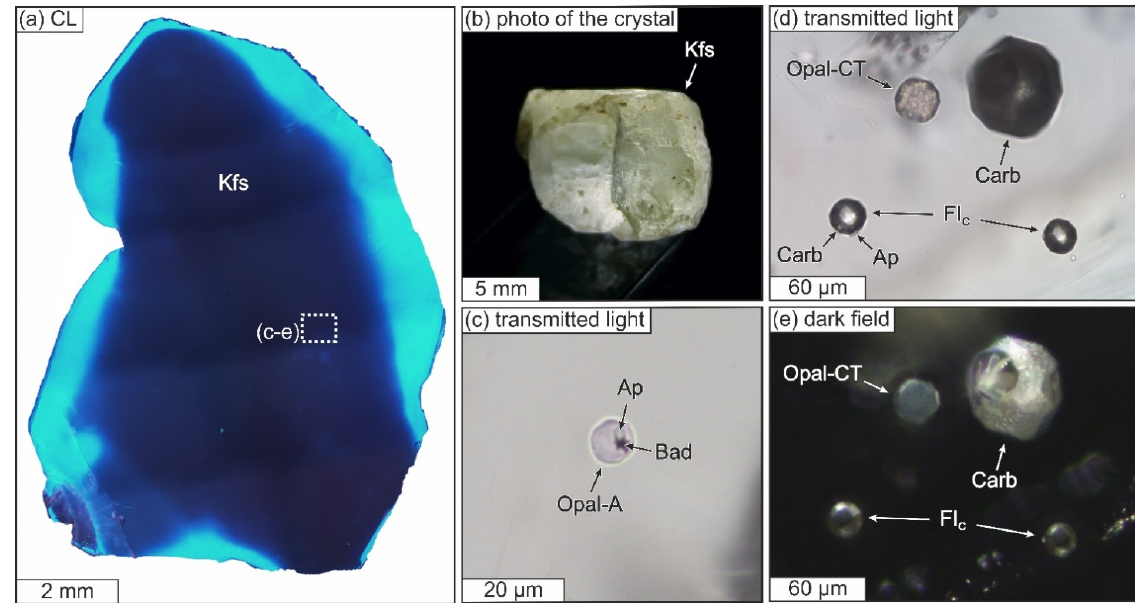
Figure 4. The crystal of gem-quality K-feldspar from our previous study [64] and its inclusions. ( a ) CL image of the crystal. ( b ) Photograph of the crystal with illumination from below. ( c ) Transmitted light image of an opal-A inclusion with prisoner crystals of apatite (Ap) and baddeleyite (Bad). ( d , e ) Transmitted light ( d ) and dark field ( e ) images of a group of inclusions with one opal-CT inclusion, one carbonate (Carb) inclusion and two CO 2 -rich fluid (Fl c ) inclusions with daughter carbonate (Carb) and apatite (Ap). Pronounced faceting of all the inclusions in ( c – e ) indicates that their content remained fluid after the entrapment at least for time sufficient to allow K-feldspar to recrystallise. Details concerning the identification of phases other than varieties of opal can found in [64].